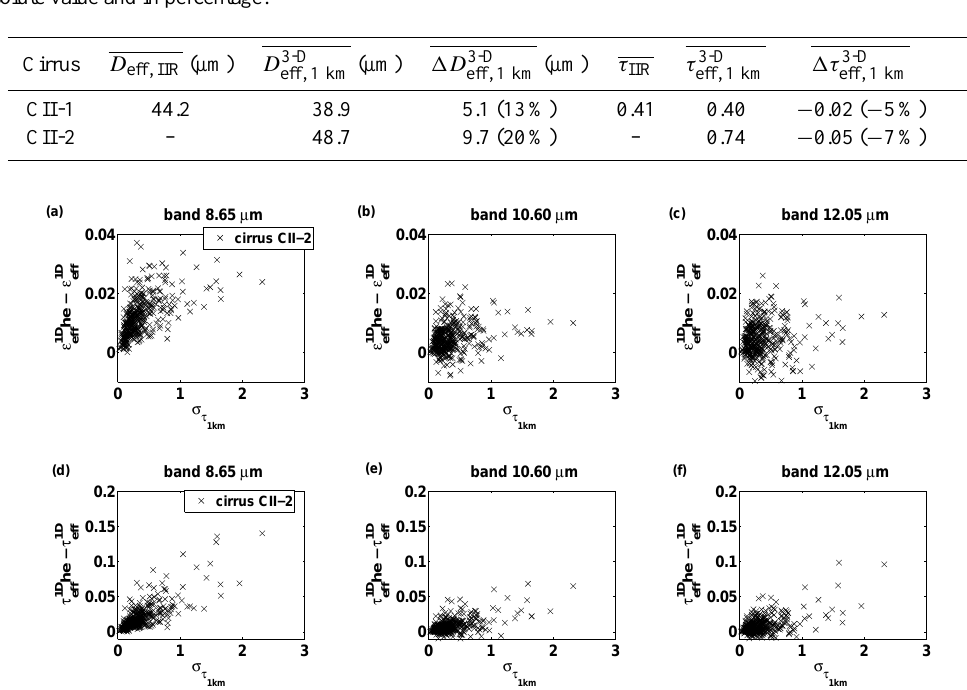
Table 2. D eff,IIR and τ IIR : averaged effective diameter and optical thickness, respectively, retrieved by IIR on 25 May 2007 during the CIRCLE-2 campaign; D 3-D ; and τ 3-D : averaged effective diameter and optical thickness, respectively, retrieved for CII-1 and CII-2 eff, 1 km 1 km cirrus and (cid:49)D 3-D and (cid:49)τ 3-D : averaged errors on the effective diameter and optical thickness, respectively, due to cloud hetero- eff, 1 km eff, 1 km geneities in absolute value and in percentage.